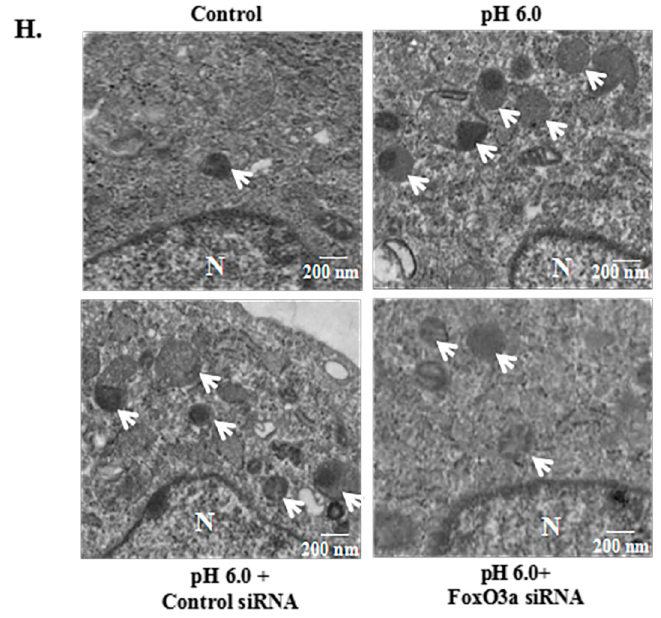
Figure 5. FoxO3a signaling is involved in ASIC1a-mediated articular chondrocytes autophagy. ( A ) rat articular chondrocytes were incubated with extracellular acid (pH 6.0) for the indicated time periods. The protein expression of FoxO3a was assessed by Western blot; ( B ) nuclear and cytoplasmic FoxO3a proteins were isolated as described in materials and methods and expression level of FoxO3a in nuclear fraction was determined by Western blot analysis; histone H3 was used as normalized control in nuclear protein; ( C ) representative immunofluorescence analysis was performed on articular chondrocytes using anti-FoxO3a (green) antibody after acid treatment for 30 min. Nuclei were counterstained with DAPI (blue). Merge contains the combined image of FoxO3a immunostaining and DAPI staining. Scale bar = 100 μ m. DAPI: 4 ′ ,6-diamidino-2-phenylindole, a fluorescent stain that binds strongly to A-T rich regions in DNA. ( D ) pretreatment with ASIC1a-specific blocker, PcTx1 and calcium chelating agent, BAPTA-AM for 1 h, articular chondrocytes were stimulated with extracellular acid (pH 6.0) for 30 min. The FoxO3a protein expression was determined by Western blotting; ( E , F ) rat articular chondrocytes were transfected with siRNA targeting FoxO3a or scrambled control siRNA. After transfection, articular chondrocytes were treated with extracellular acid; ( E ) mRNAs were isolated from articular chondrocytes and qRT-PCR was performed; ( F ) the protein expression of Beclin1, LC3B-II were determined by Western blot analysis; ( G ) rat articular chondrocytes were transfected with a mCherry-EGFP-LC3B plasmid and FoxO3a-siRNA or control-siRNA and then treated with extracellular acid, the GFP-LC3 puncta (green dots) and autophagosomes (yellow dots) and autolysosomes (red dots) were analyzed by fluorescence microscopy. Scale bar = 20 μ m; ( H ) rat articular chondrocytes were transfected with FoxO3a-siRNA or control-siRNA and then treated with extracellular acid. The ultrastructure of the chondrocytes was imaged using transmission electron microscopy. N: nucleus; White arrows: autophagosomes. All images were shown at 20,000× magnification. Data were presented as mean ± SD of three independent experiments. * p < 0.05, ** p < 0.01 versus control group; # p < 0.05, ## p < 0.01 versus pH 6.0 group.